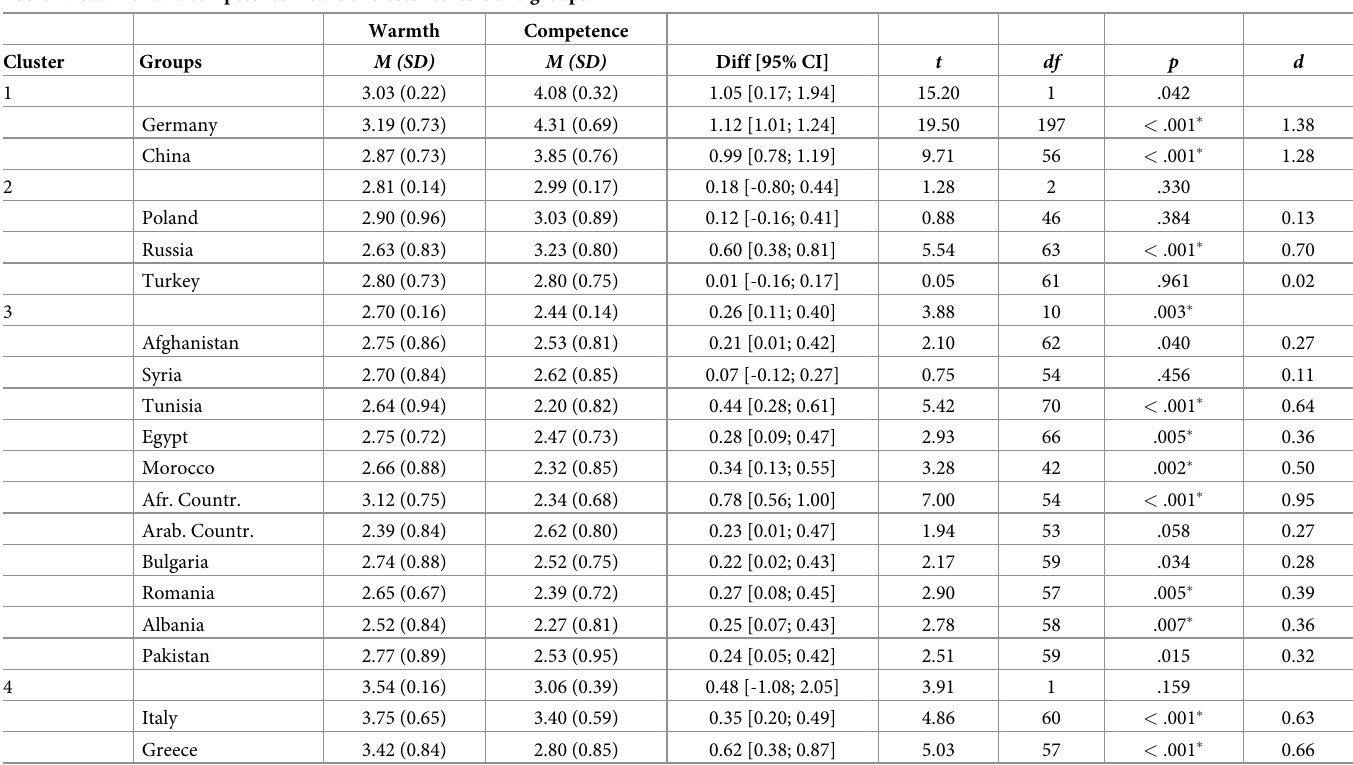
Table 1. Warmth and competence means of cluster centers and